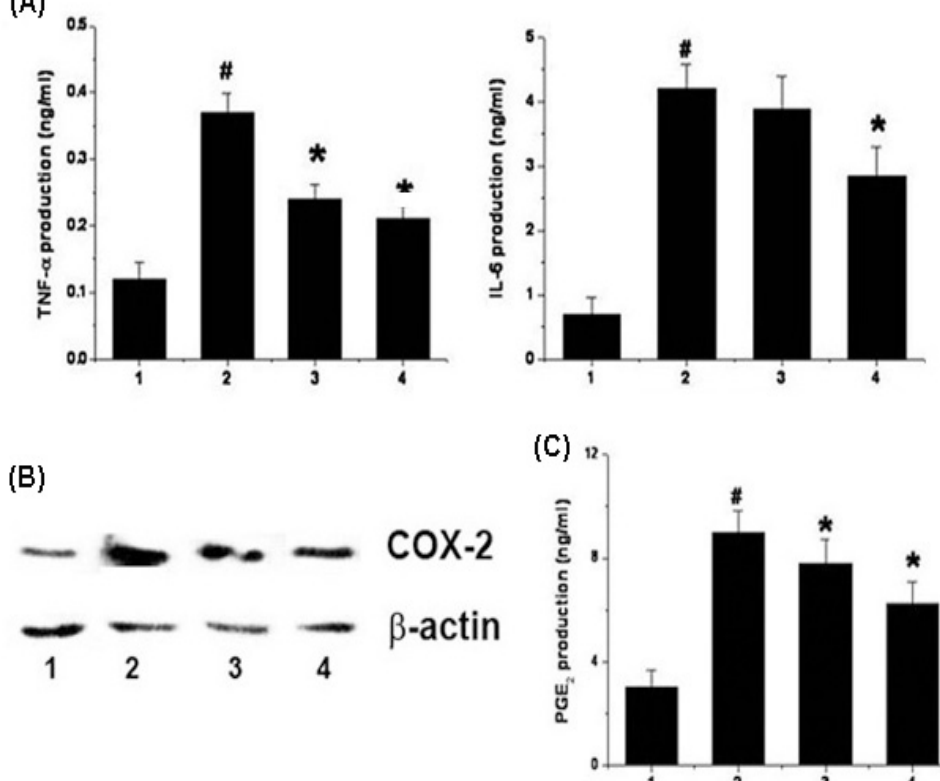
immunoassay kits . 1) unstimulated cells; 2) LPS (1 μ g/mL); 3) chrysophanol (2 μ M) plus LPS (1 μ g/mL); 4) chrysophanol (20 μ M) plus LPS (1 μ g/mL). All data were